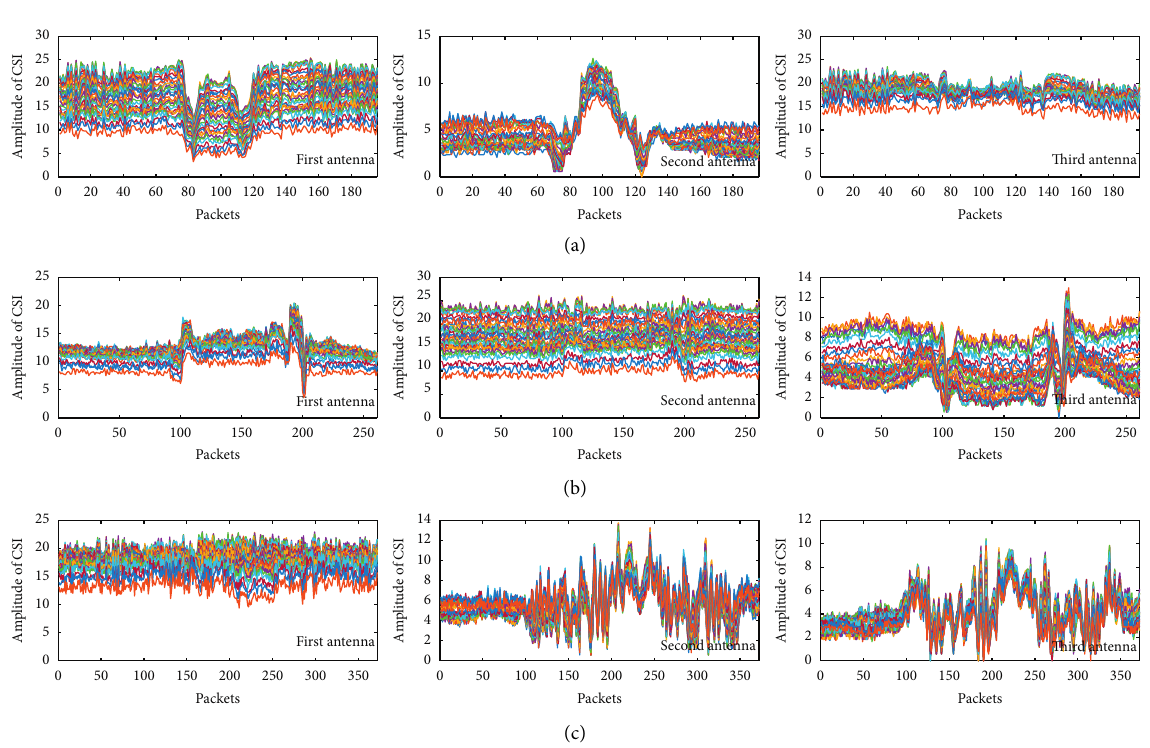
Figure 3: Raw signals of three antennas with different activities: (a) bend; (b) clap; (c)